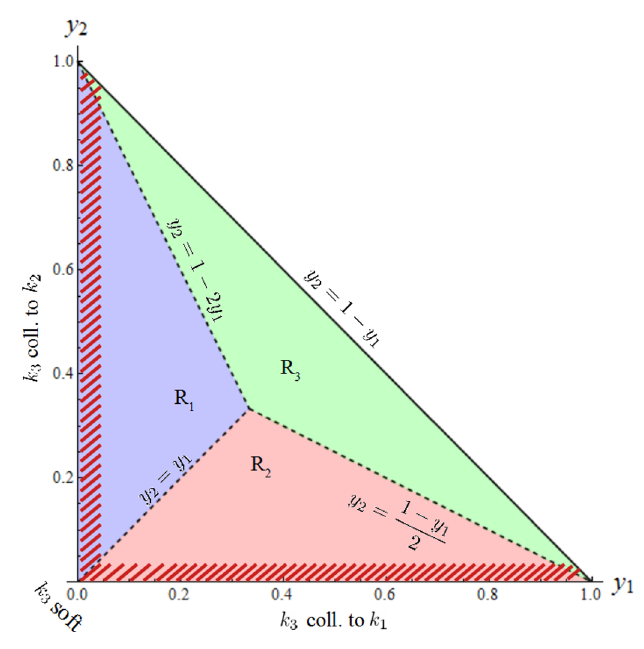
correspond to a value of thrust given by τ = y i